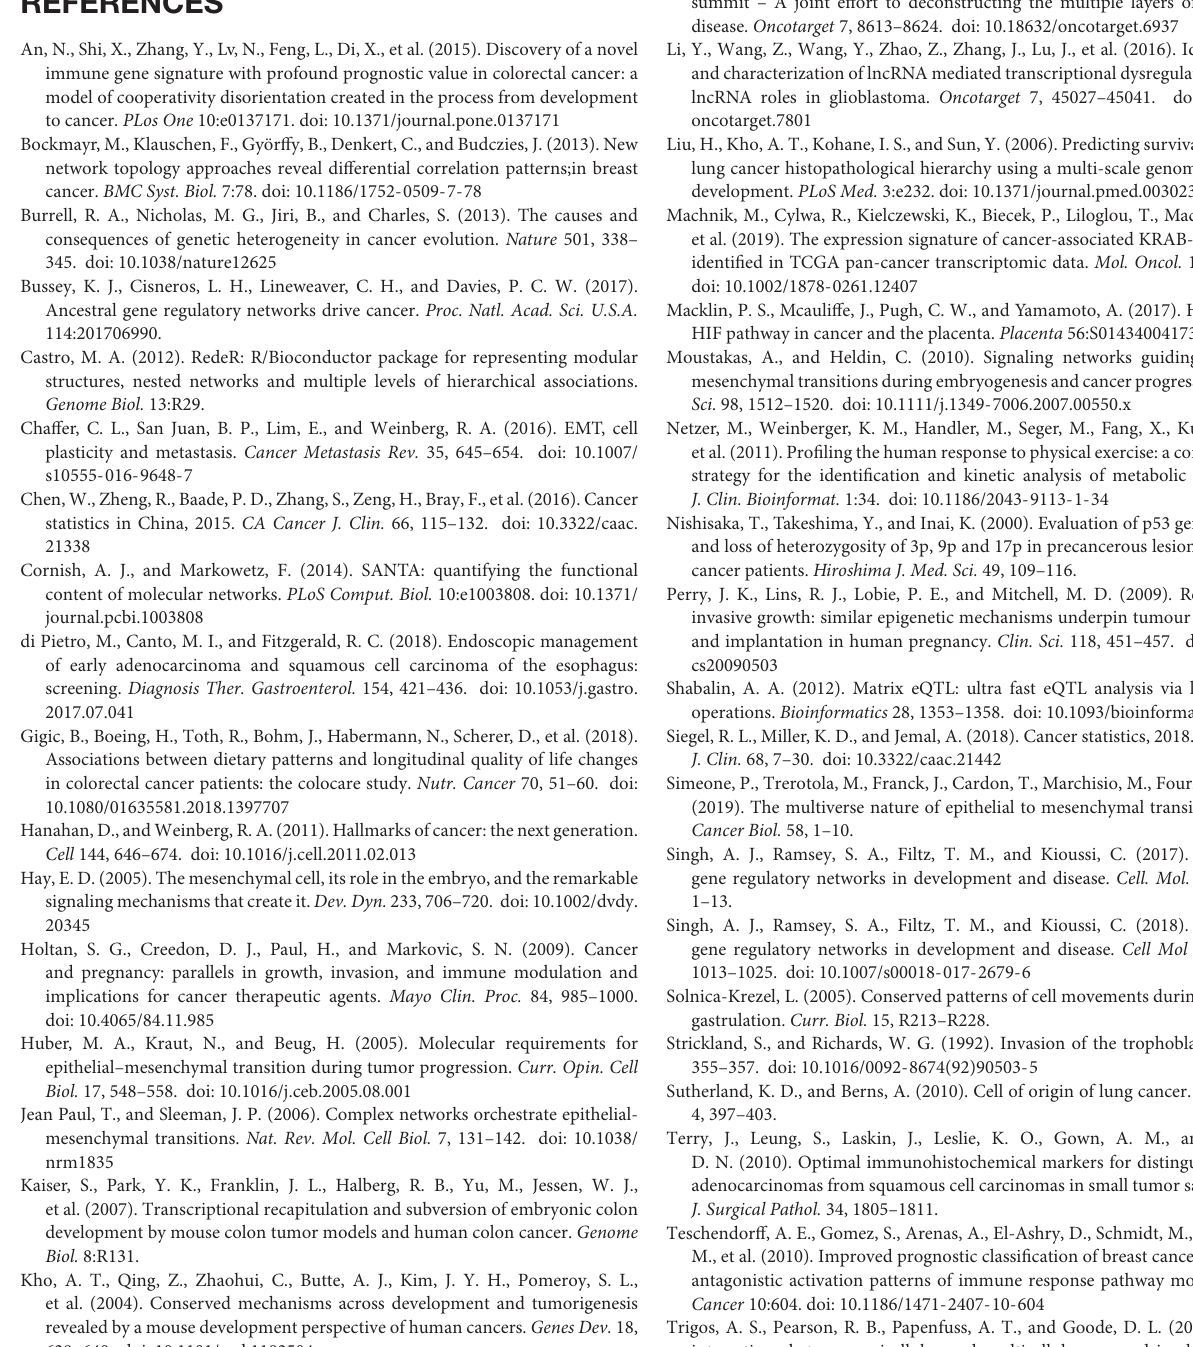
TABLE S4 | Cox pro portional hazards regression analysis of OS in COAD. TABLE S5 | Cox proportional hazards regression analysis of OS in EAC. TABLE S6 | Cox proportional hazards regression analysis of OS in ESCC. TABLE S7 | Cox proportional hazards regression analysis of OS in GBMLGG.